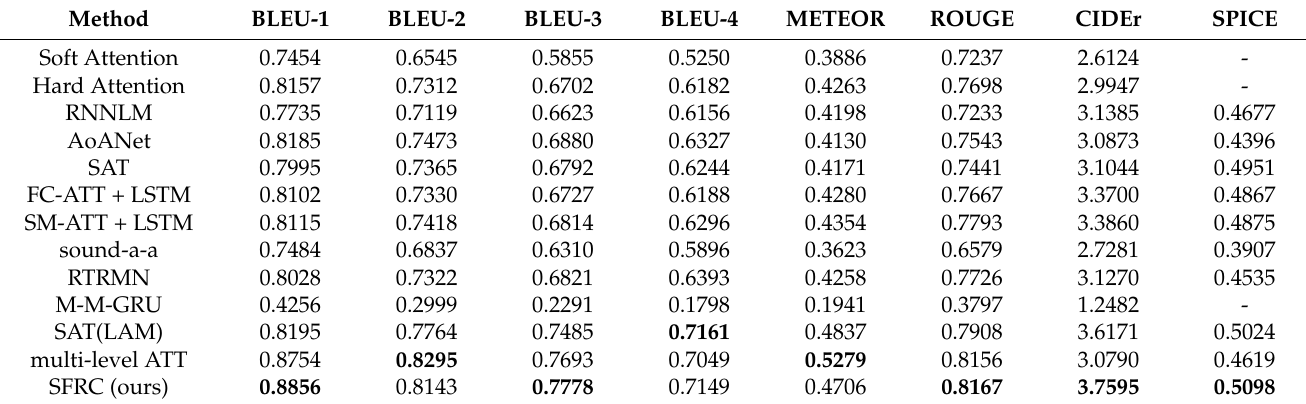
Table 1. Quantitative comparison results on UCM-Captions dataset.